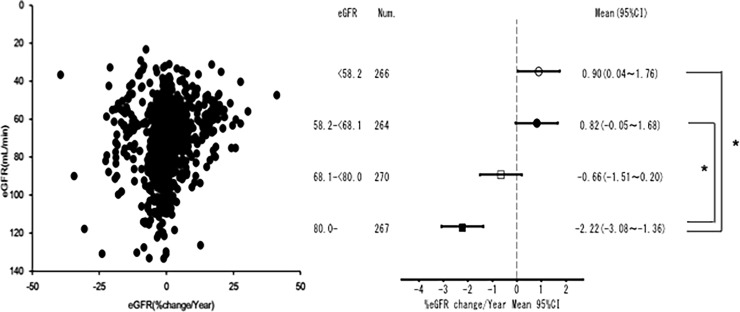
Decline in eGFR in participants without diabetes with normo- or microalbuminuria.Participants with the highest eGFR (≥80 mL/min) had a faster decline in eGFR than those with eGFR <68.1 mL/min. Num.: Number. 95%CI: 95% confidence interval. *P <0.01.